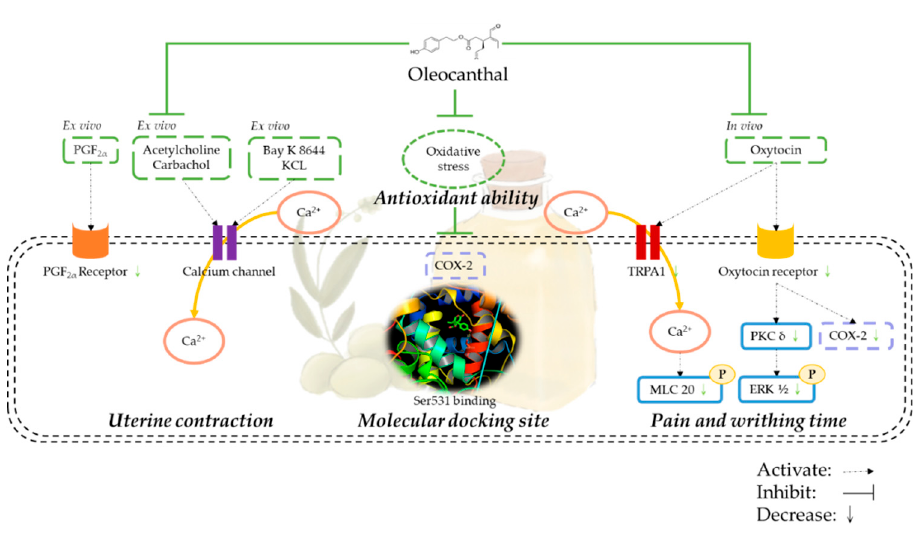
Figure 7. Schematic representation of the inhibitory e ff ect of Oleocanthal (OC) on uterine hyper-contraction by the inhibition of calcium influx and the contraction signaling pathway and the use of a similar binding site to ibuprofen. PGF2 α : prostaglandin F2 α , KCL: potassium chloride, COX-2: cyclooxygenase-2, TRPA1: transient receptor potential ankyrin 1, MLC20: myosin light chain-20, PKC δ : protein kinase c- δ , ERK1 / 2: extracellular signal-regulated kinase 1 / 2. Supplementary Materials: The following are available online at http: // www.mdpi.com / 2072-6643 / 12 / 10 / 3012 / s1. Figure S1: E ff ect of OC prostaglandin F2 α (PGF2 α ), oxytocin (OT), acetylcholine (Ach), and carbachol (Car)-induced uterine contraction in an ex vivo study. Figure S2: Examine the cytotoxicity e ff ect of oleocanthal. Figure S3: E ff ect of solvent DMSO on uterine contraction. Figure S4: Representative UPLC